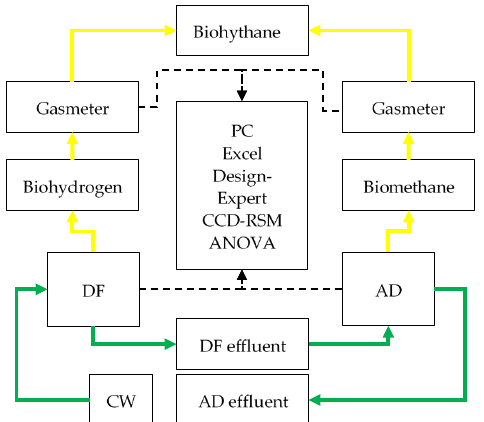
Figure 1. Flowchart of energy production optimization in mesophilic–thermophilic two-stage AD of CW. Note: Green lines indicate liquid flow, yellow lines indicate gas flow and dotted lines indicate information